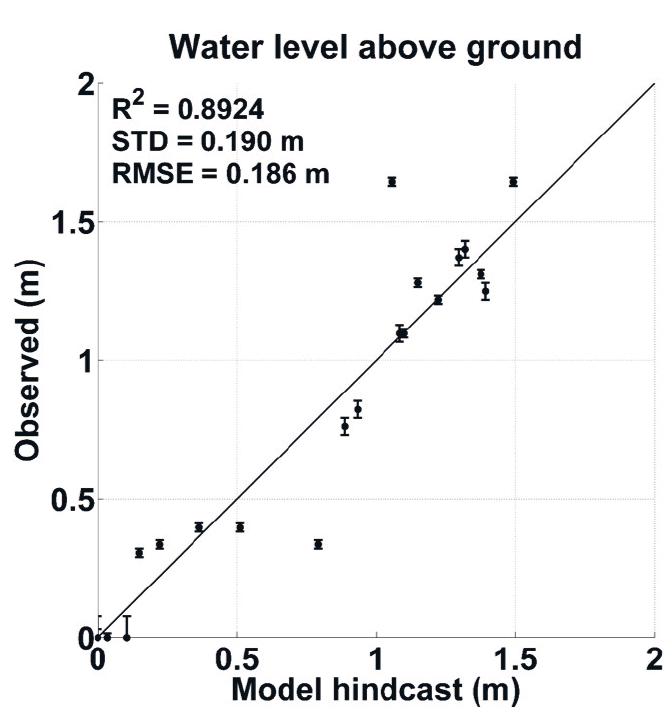
Figure 5. Sandy simulation vs . Jamaica Bay high water marks (HWMs). Error bars on the observed water levels come directly from the USGS field report for each HWM.